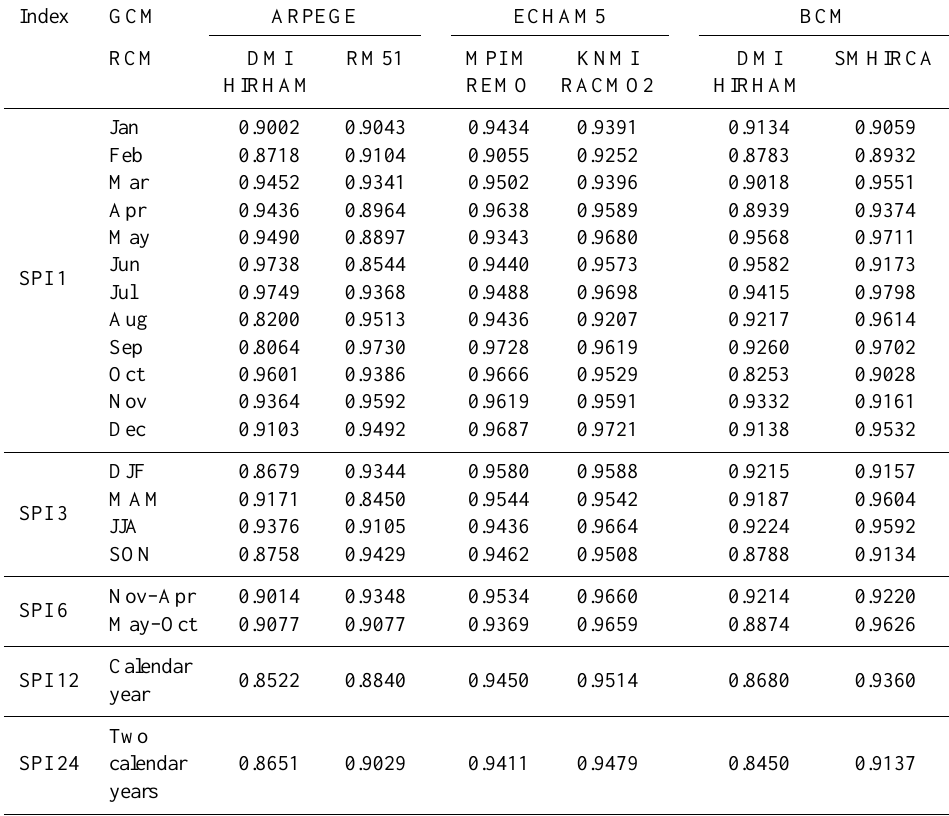
Table 3. Estimated values of Pearson correlation coefficient between raw and corrected SPI time series for six climate models. A minimum value over all grid cells is